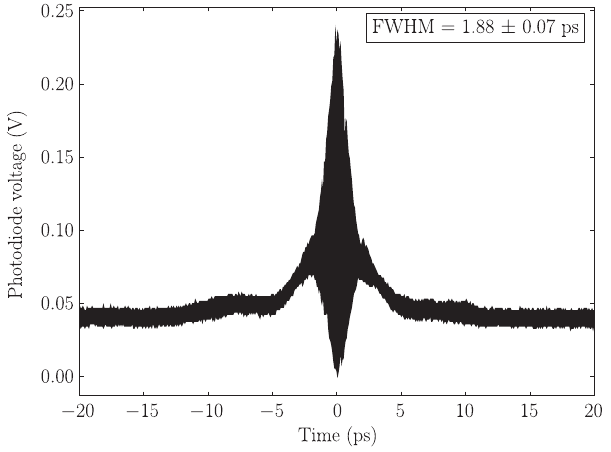
FIG. 12. Autocorrelation of the unamplified compressed seed pulses transmitted through the PCF.